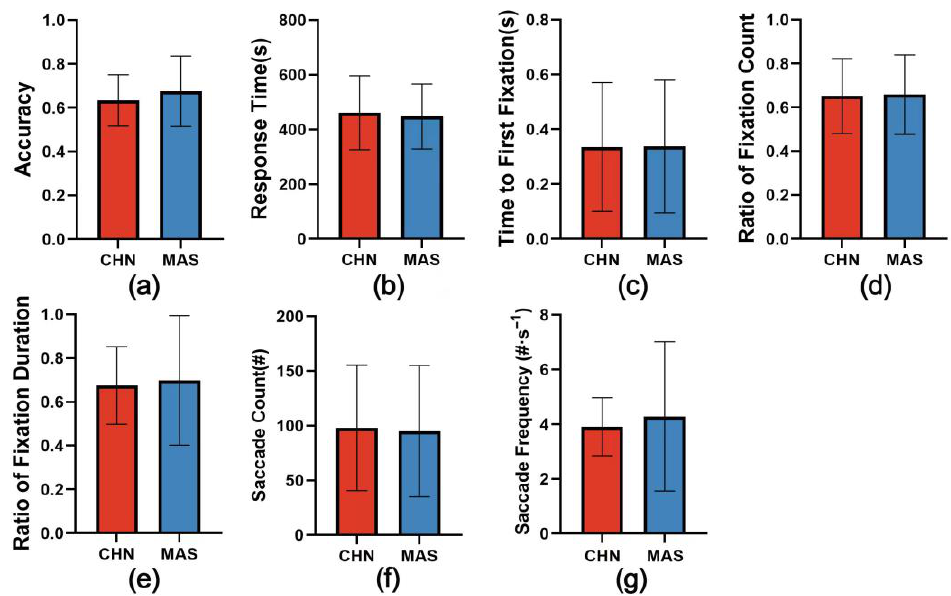
Figure 5. Statistics in the spatial visualization task: ( a ) accuracy; ( b ) response time; ( c ) time to first fixation; ( d ) ratio of fixation count; ( e ) ratio of fixation duration; ( f ) saccade count; ( g ) saccade frequency (* p < 0.05, ** p < 0.01).